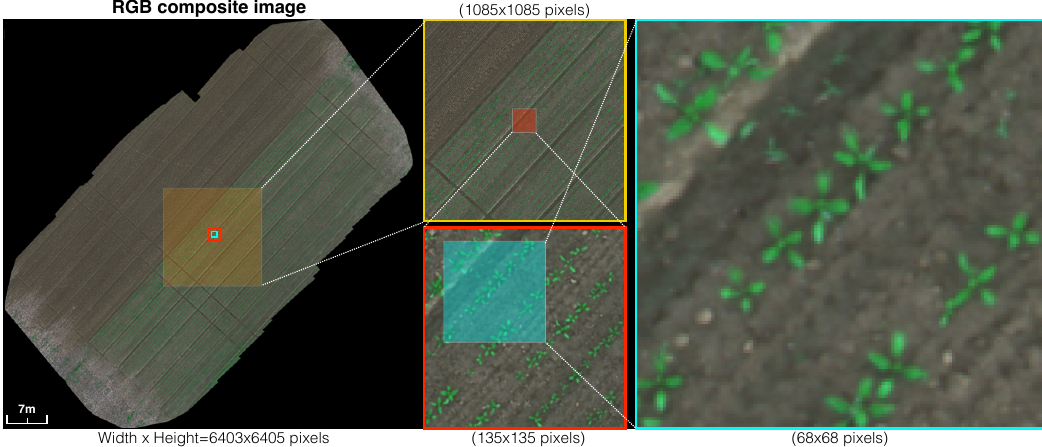
Figure 5. One of the datasets used in this paper. The left image shows the entire orthomosaic map, and the middle and right are subsets of each area at varying zoom levels. The yellow, red, and cyan boxes indicate different areas on the field, corresponding to cropped views. These details clearly provide evidence of the large scale of the farm field and suggest the visual challenges in distinguishing between crops and weeds due to the limited number of pixels and similarities in